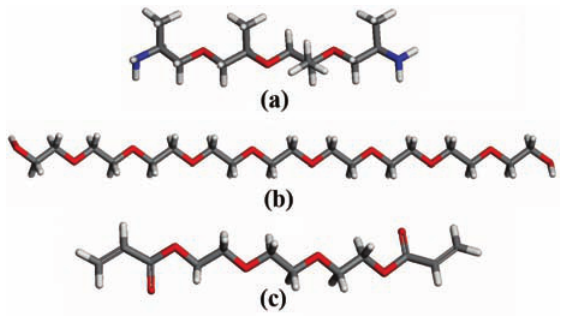
Fig. 1 – Structure of (a) poly(propylene oxide) diamine (PPO–NH 2 ), molecular weight M w = 248 g mol –1 , (b) poly(ethylene glycol) (PEG), M w = 414 g mol –1 and (c) poly(ethylene oxide) diacrylate M w = 258 g mol –1 as used in the simulations presented in this